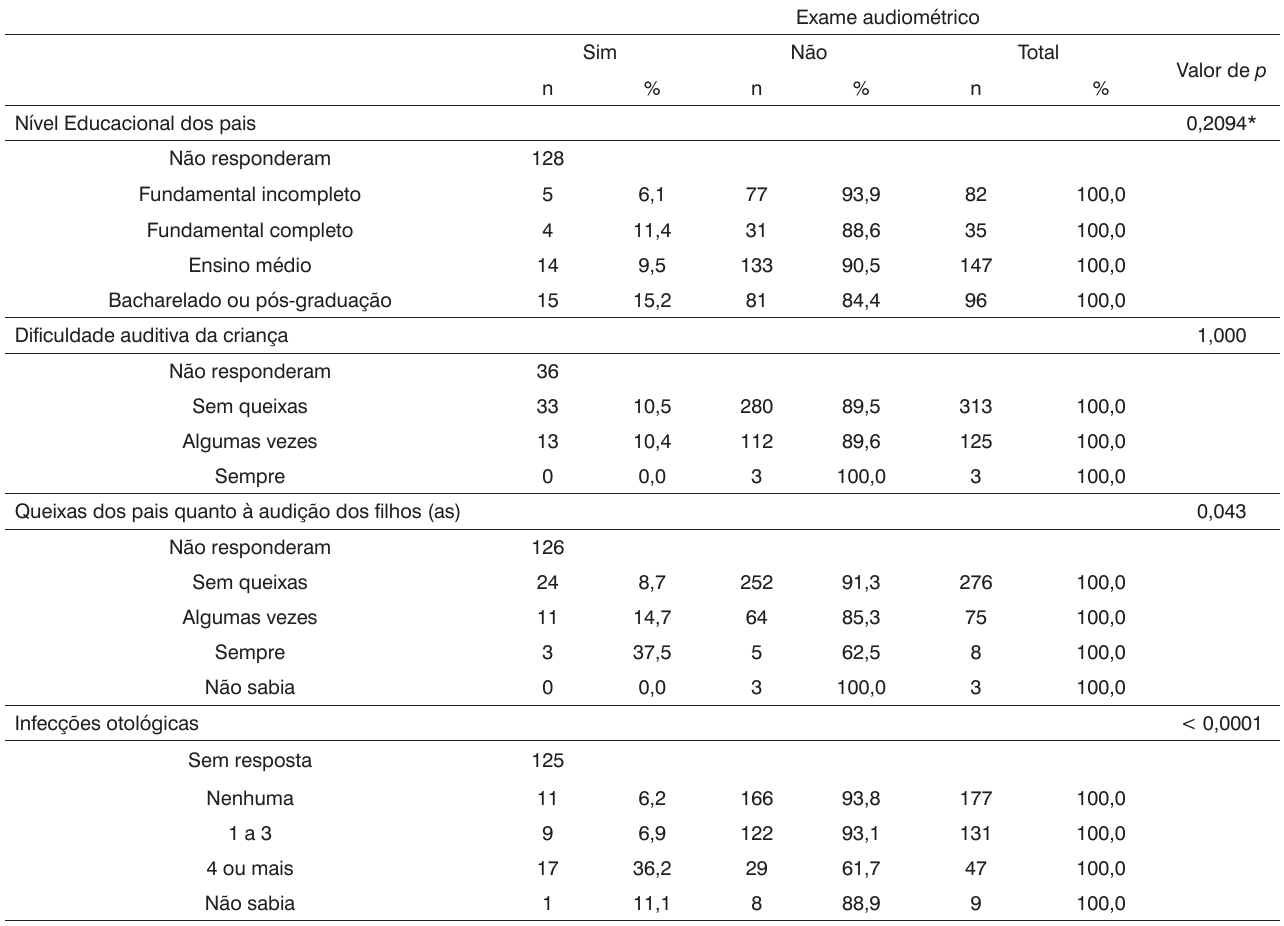
Tabela 2. Exame audiométrico relacionando o nível educacional dos pais, queixas das crianças e dos pais, e história de infecções de